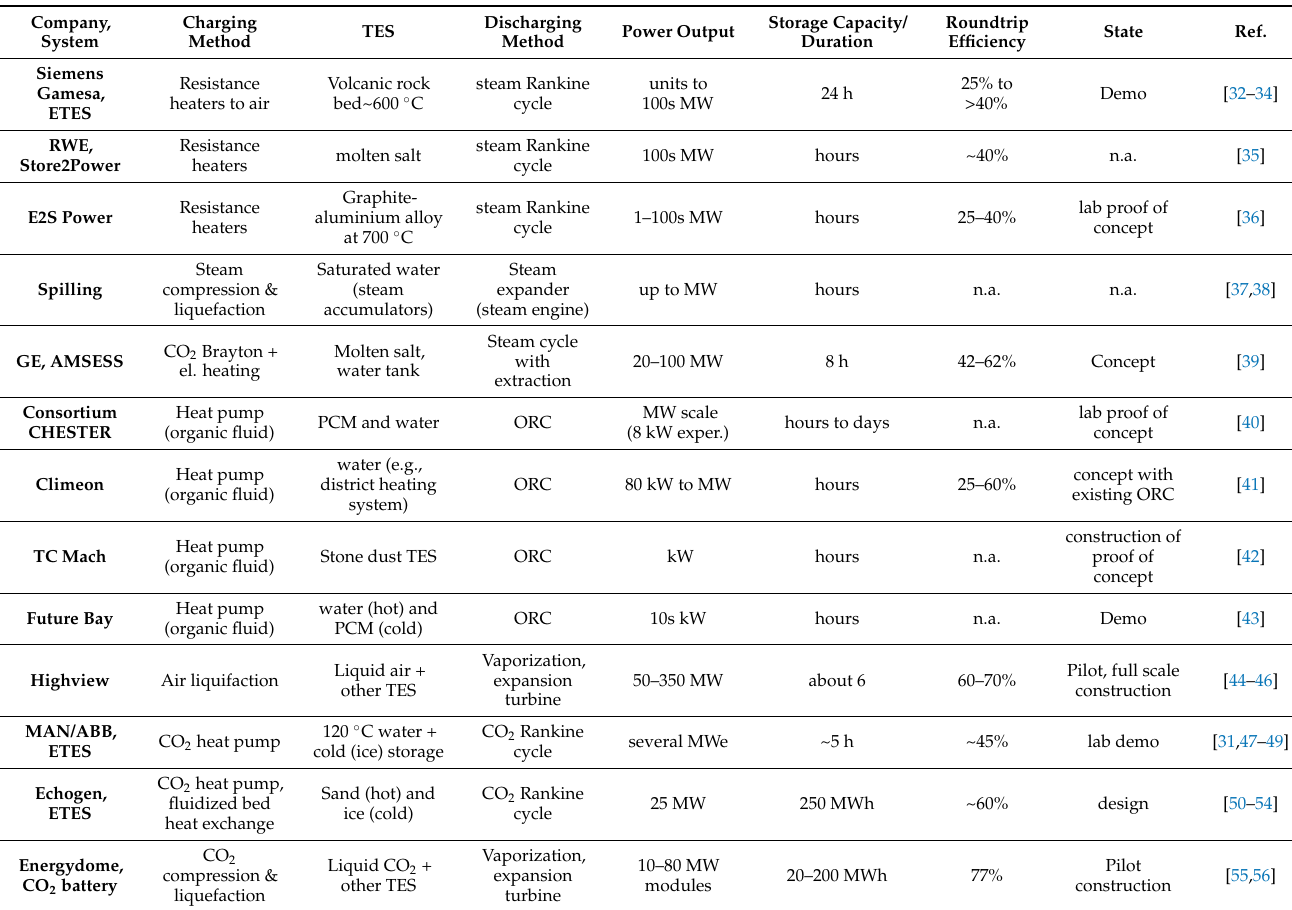
Table 1. List of commercial development projects in CB using Rankine cycle